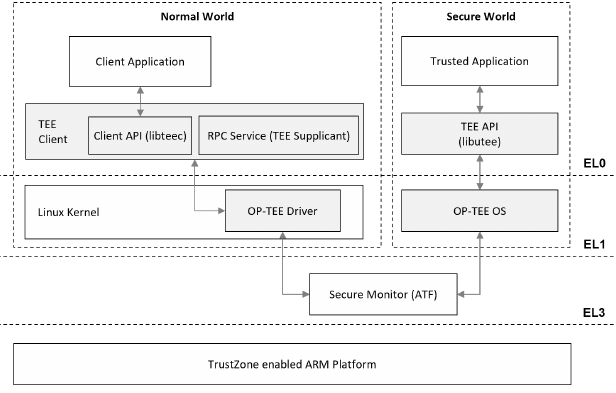
Figure 10. OP-TEE reference architecture, modified from